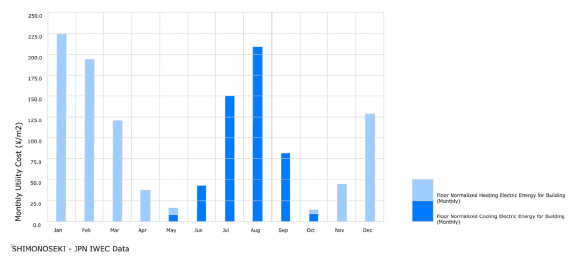
Fig. 9. Monthly utility costs for minimum surface radia- tion model.